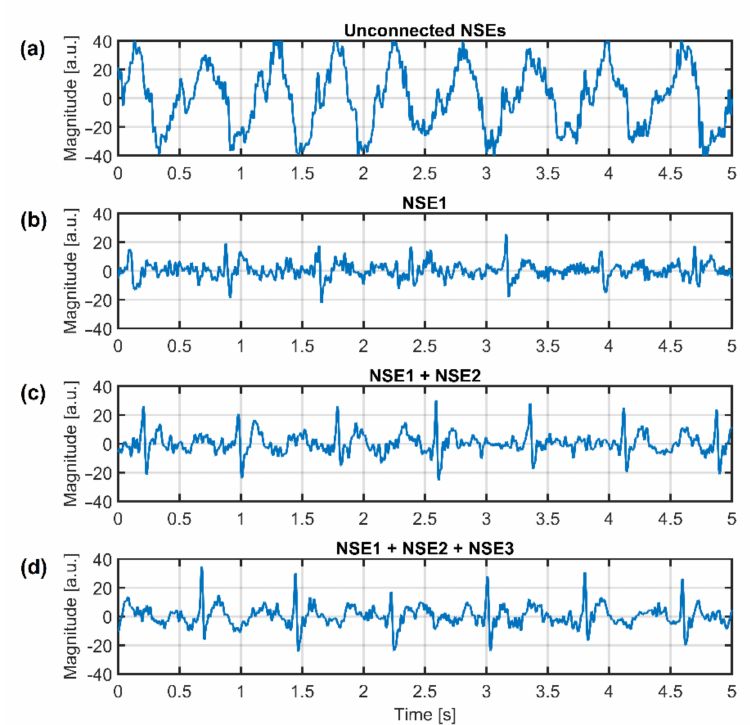
Figure 18. Filtered ECG data with gradually connected grounding electrodes—no grounding elec- trode ( a ), one grounding electrode ( b ), two grounding electrodes ( c ), and three grounding electrodes ( d